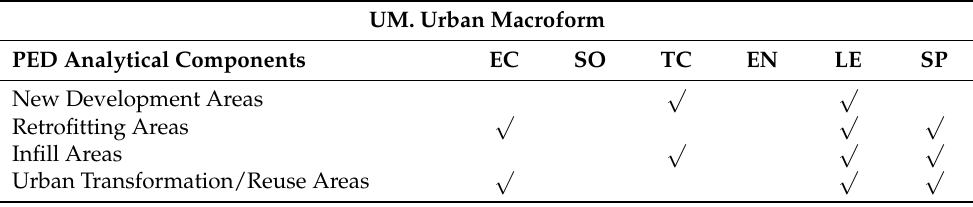
Table 8. Criteria considered for Urban Macroform PED analytical components analysis.